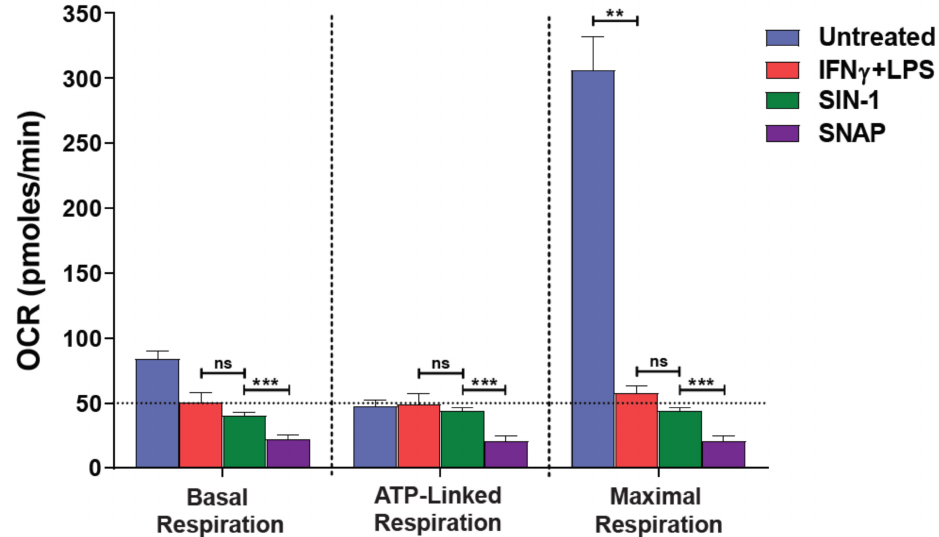
Figure 1. NO • and O 2 •− donors mimic the respiration profile of 2-signal activated macrophages. Macrophages were activated for 24 h with 40 ng/mL IFN γ plus 10 ng/mL LPS or not (untreated) and subjected to serial injections of 2 µ M oligomycin (ATP production), 1 µ M FCCP (Maximal respiration) and 2/2 µ M antimycin A/rotentone, according to the “mitostress” protocol. A Seahorse XFe96 metabolic analyzer was used to record the changes in the oxygen consumption rate (OCR). The reactive species-donors SIN-1 (NO • and O 2 •− ) or SNAP (NO • ) were added, at the concentration of 3 mM each, prior to the assay in cell-free wells. The last OCR measurement in sequence before addition of oligomycin was used to represent the basal respiration. Two-tailed Mann-Whitney U tests or the Kruskal-Wallis test (with the Benjamini- Krieger-Yekutieli two-stage linear step-up, or with the Dunn’s, procedure) were used for comparisons. ns: not significant, ** p < 0.01, *** p < 0.001. Horizontal intermittent line indicate the basal OCR levels of IFN γ + LPS activated macrophages. One representative experiment is shown, with data presented as mean ± STD of at least three replicates per